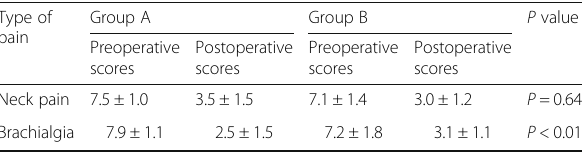
Table 3 Patient ’ s clinical outcome according to VAS pain scores at end follow-up